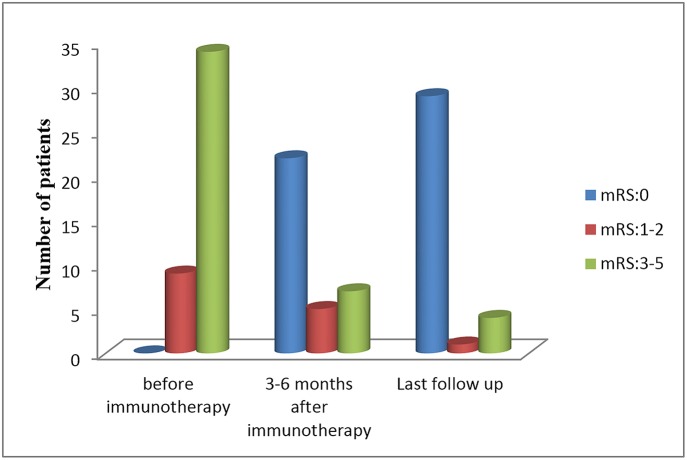
Patients' mRS scores during the follow-up period.